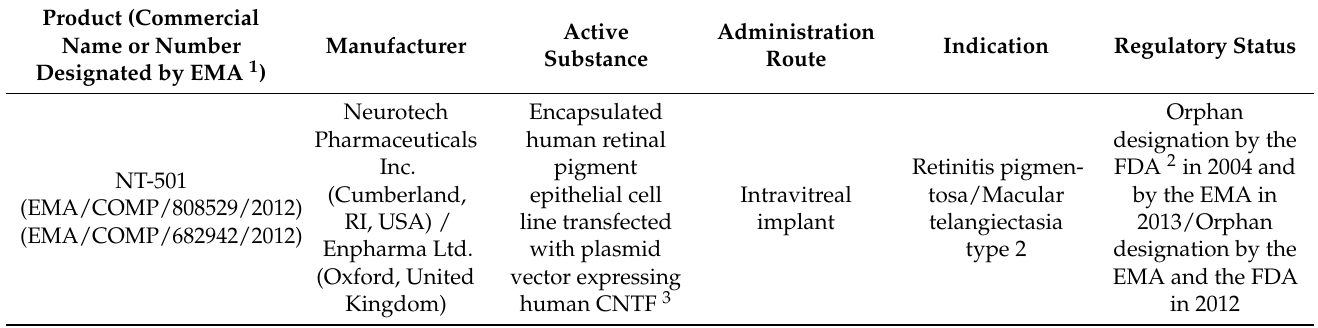
Table 4. Combined advanced therapy medicinal product for the